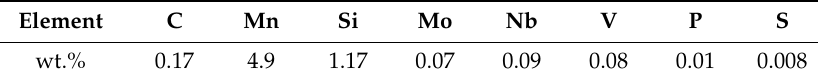
Table 1. Chemical compositions of the experimental steel (in weight